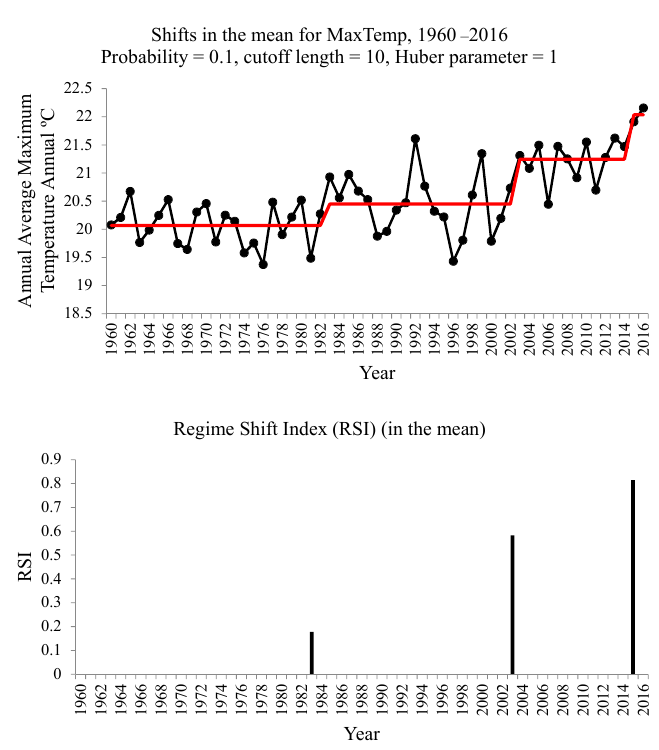
Figure 10. Red line in the upper diagram is the stepwise trend showing regime shifts in the mean of the annual average maximum temperature detected by the sequential t -test for analyzing regime shift (STARS) method; black solid bars in the lower diagram are the RSI magnitude.